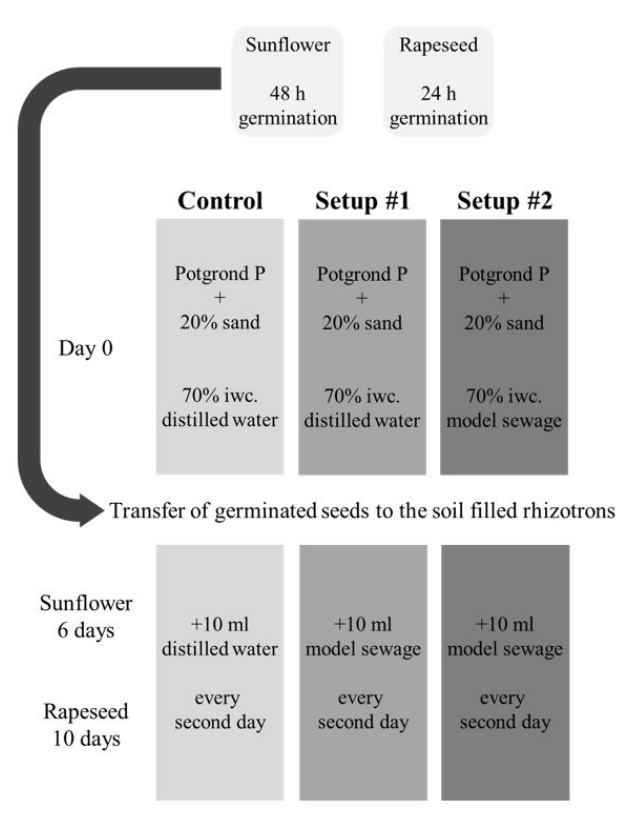
Figure 1. Schematic scheme of the applied growth and treatment system.